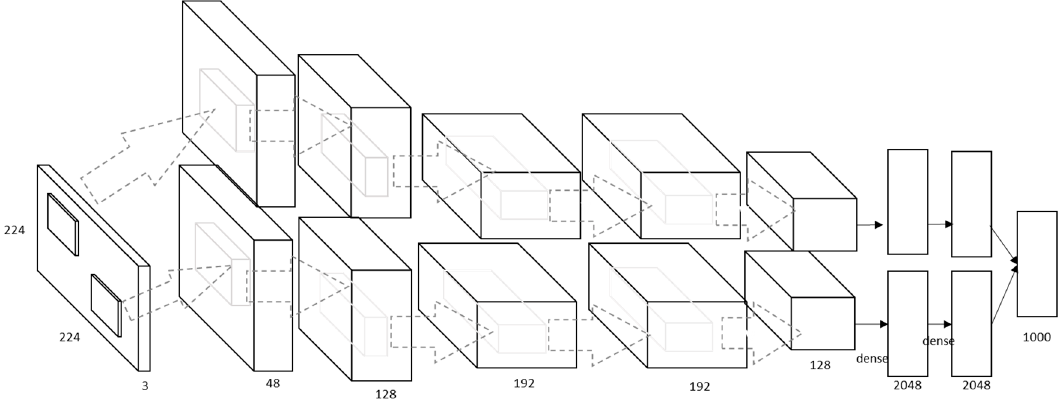
Figure 3. Architecture (our own redrawing) of AlexNet [30].